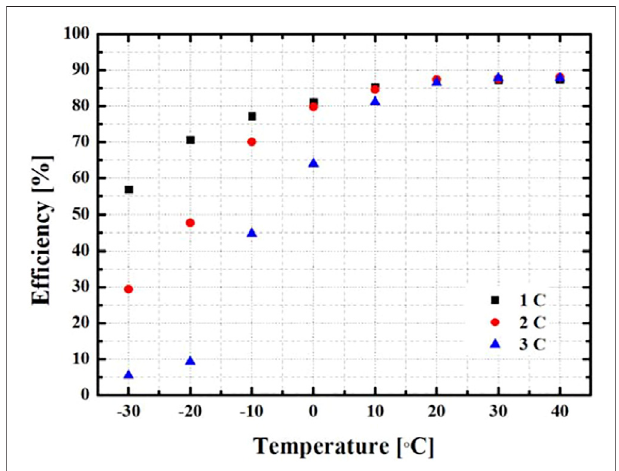
FIGURE 7 | Discharge ef fi ciency according to the environmental temperature change.